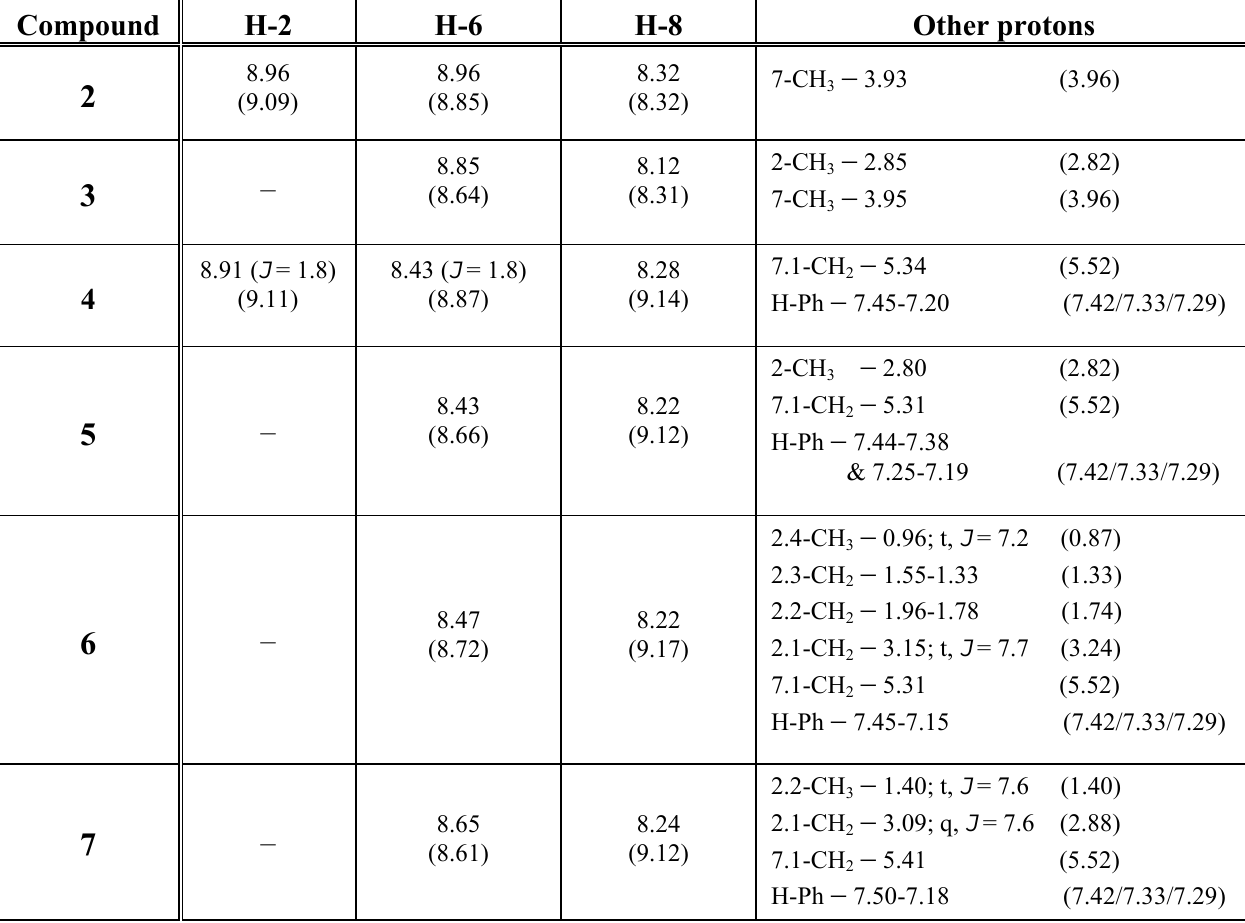
Table 1 . 1 H-NMR spectra of purine N -oxides (in CDCl